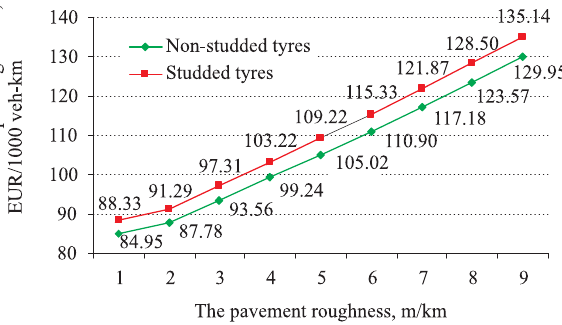
Fig. 2. Evaluation of the fuel costs of passenger cars using non- studded and studded tyres (Accumulation and renewal of traffi c data of the roads of national signifi cance, 2008)